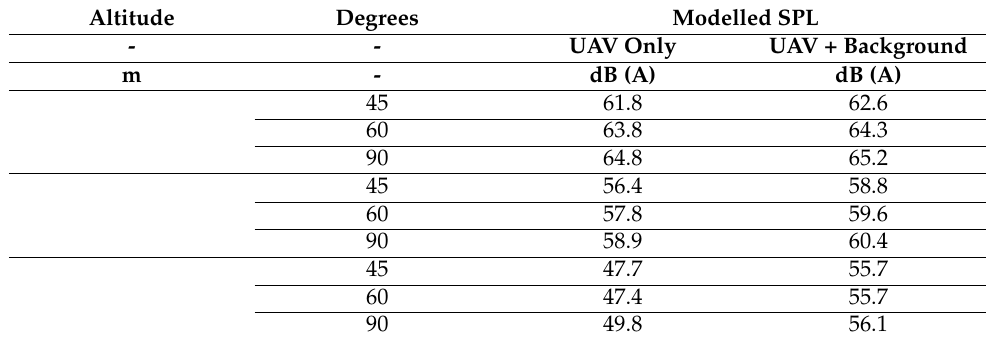
Table 6. Grand Canal Dock model results